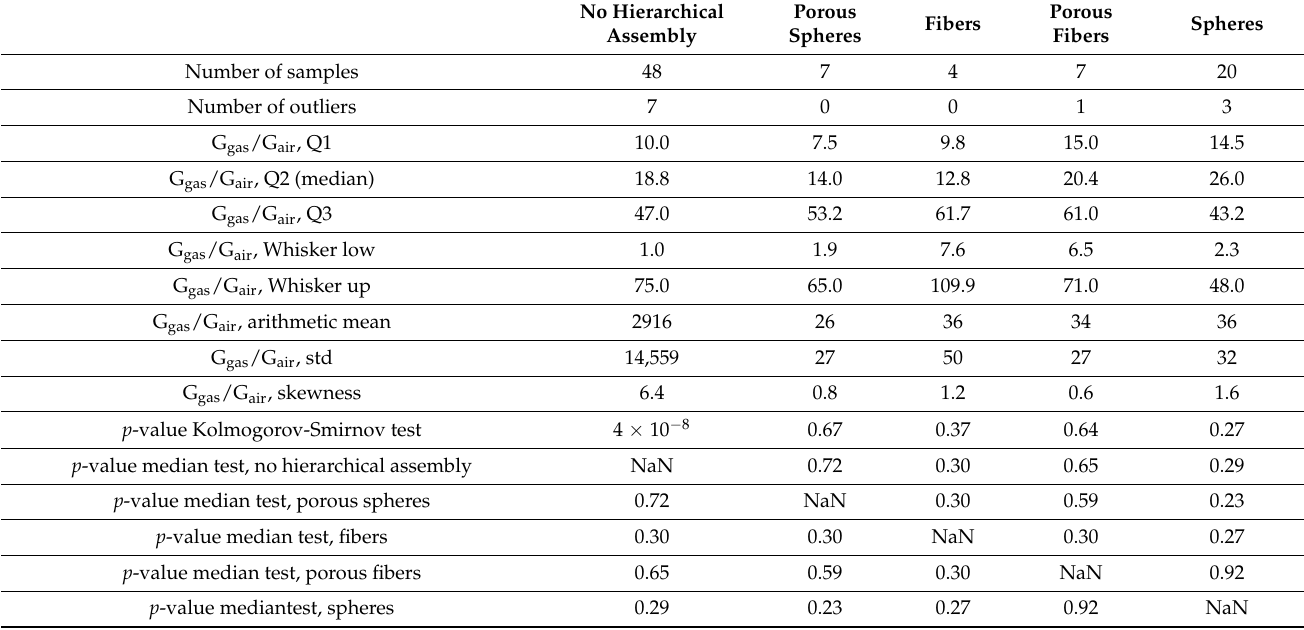
Table 2. Statistical analysis of responses G gas /G air to 100 ppm of ethanol grouped by crystallite assembly shown in Figure